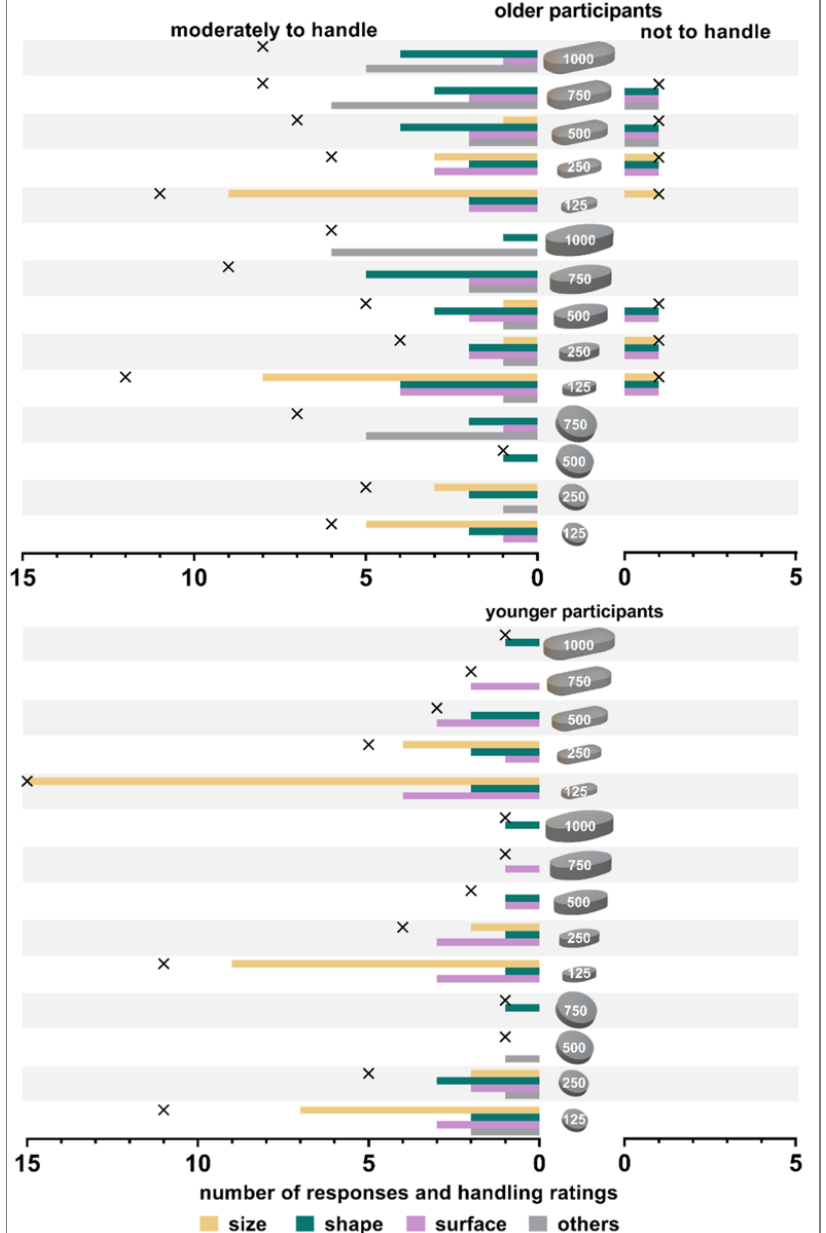
Figure 4. Number of responses and handling ratings ( moderately to handle on the left panels and not to handle on the right panels). Crosses indicate the number of handling ratings (absolute numbers). Data are shown separately for the older participants ( top panels) and younger participants ( bottom panels).